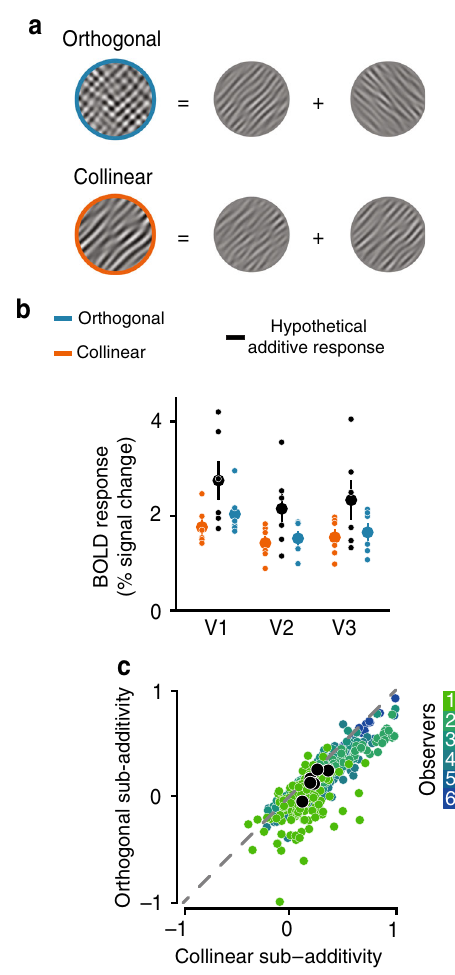
Fig. 1 Sub-additivity as a measure of tuned normalization. a Schematic of stimuli used to measure sub-additivity. Two oriented stimuli components (outer diameter 15°; inner diameter 3°, at 50% Michelson contrast, spatial frequencies between 2 and 3 cycles/°; orientation bandwidth of 10°) were linearly summed in either an orthogonal (top; blue) or a collinear (bottom; orange) con fi guration, resulting in a full contrast stimulus. Stimuli are modi fi ed for illustrative purposes. b Average BOLD responses across observers for orthogonal (blue) and collinear (orange) con fi gurations. A hypothetical additive response (black) was created by summing the average response evoked by both individual stimulus components (45° & 135°). Dots represent individual observers; N = 6; error bars denote ± 1 S.E.M. c Voxel-wise relationship of the deviation from additivity for both stimuli con fi gurations in V1. BOLD responses were normalized for each participant. Small colored dots indicate individual voxels; larger black dots represent the whole ROI average per normalization, while comparing the difference between responses evoked by the two overlaid con fi gurations served as our measure for an additional tuned component.